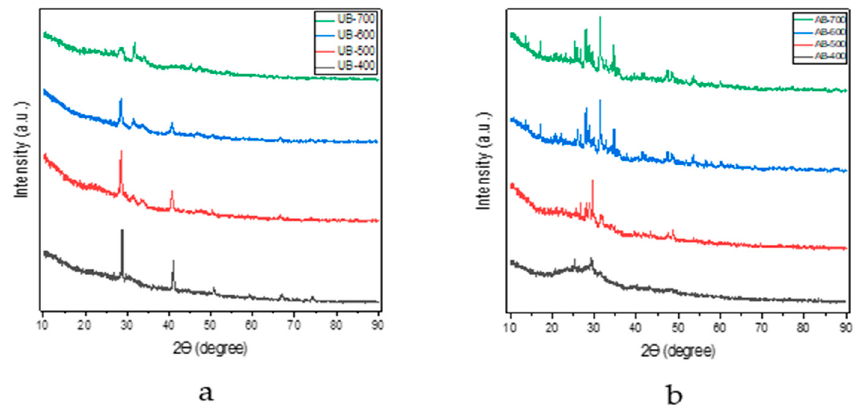
Figure 5. X-ray diffraction pattern of ( a ) unactivated biochar (UB) and ( b ) activated biochar (AB) synthesized at temperatures of 400–700 °C.